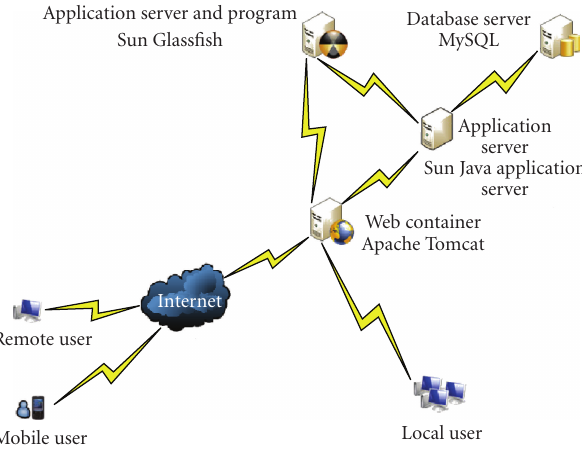
Figure 4: Mobile device interface.